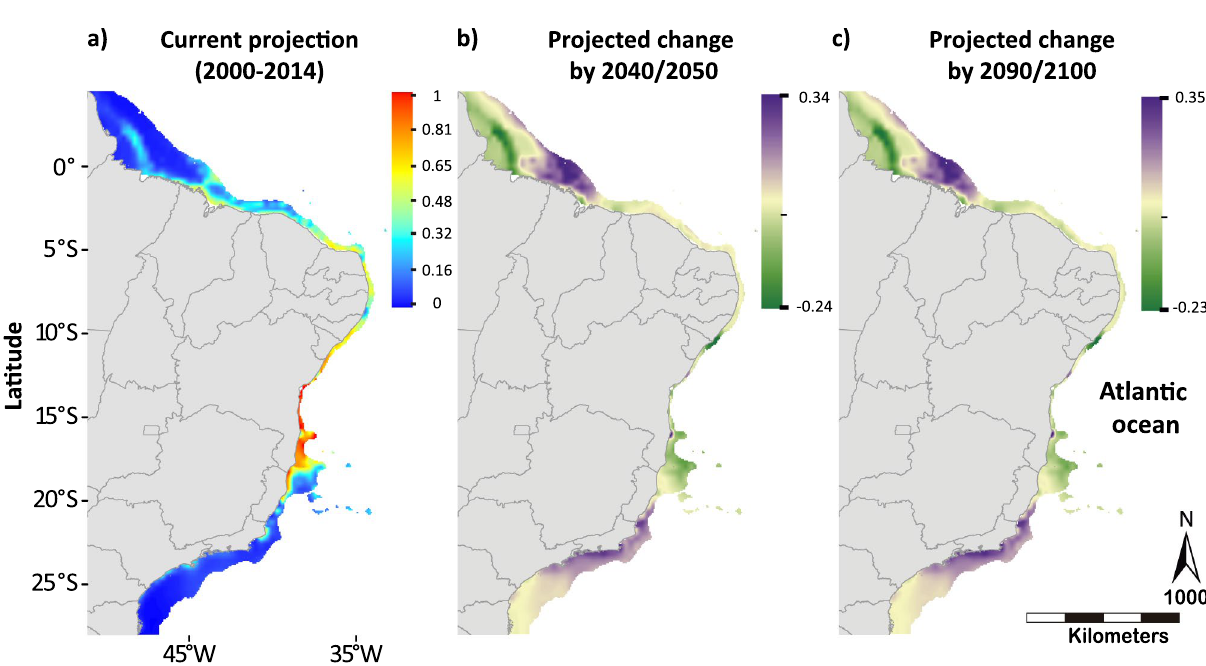
Figure 3. Probability map of vulnerability for the current scenario and delta maps of projected changes between current and future scenarios. ( a ) Vulnerability areas based on the overlap of coral occurrence, coral cover and coral bleaching probabilities of the Brazilian coast for the current (2000–2014) scenario and ( b , c ) delta maps between current and the future scenarios (2040–2050 minus 2000–2014, left; and 2090–2100 minus 2000–2014, right) under a “business as usual” warming rate (RCP 8.5). The blue-red and green-purple scale bars represent absolute probability values and delta probability values, respectively. Maps created in ArcMap version 10.2 (https:// deskt op. arcgis. com/ en/